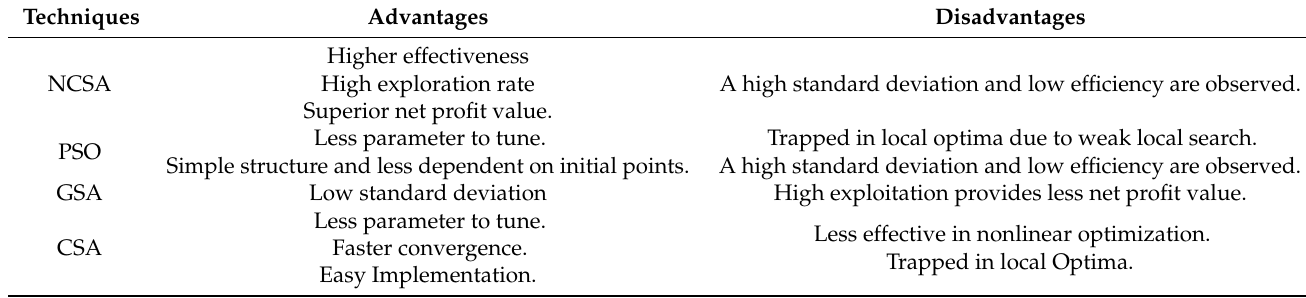
Table 11. Advantages and disadvantages of discussed